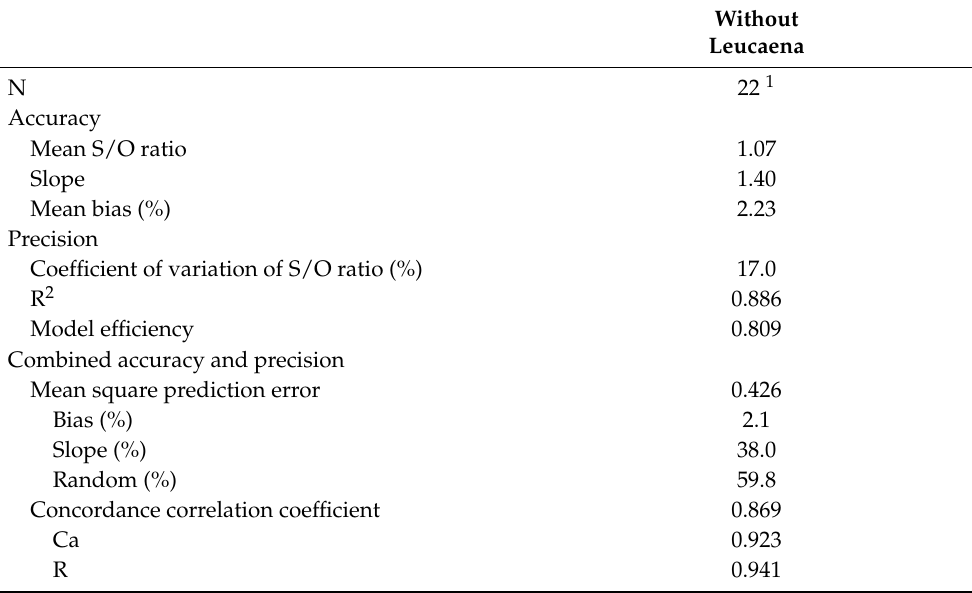
Table 3. Descriptors of accuracy and precision of the RUMINANT model to simulate dry matter intake (DMI) on forage diets without and with